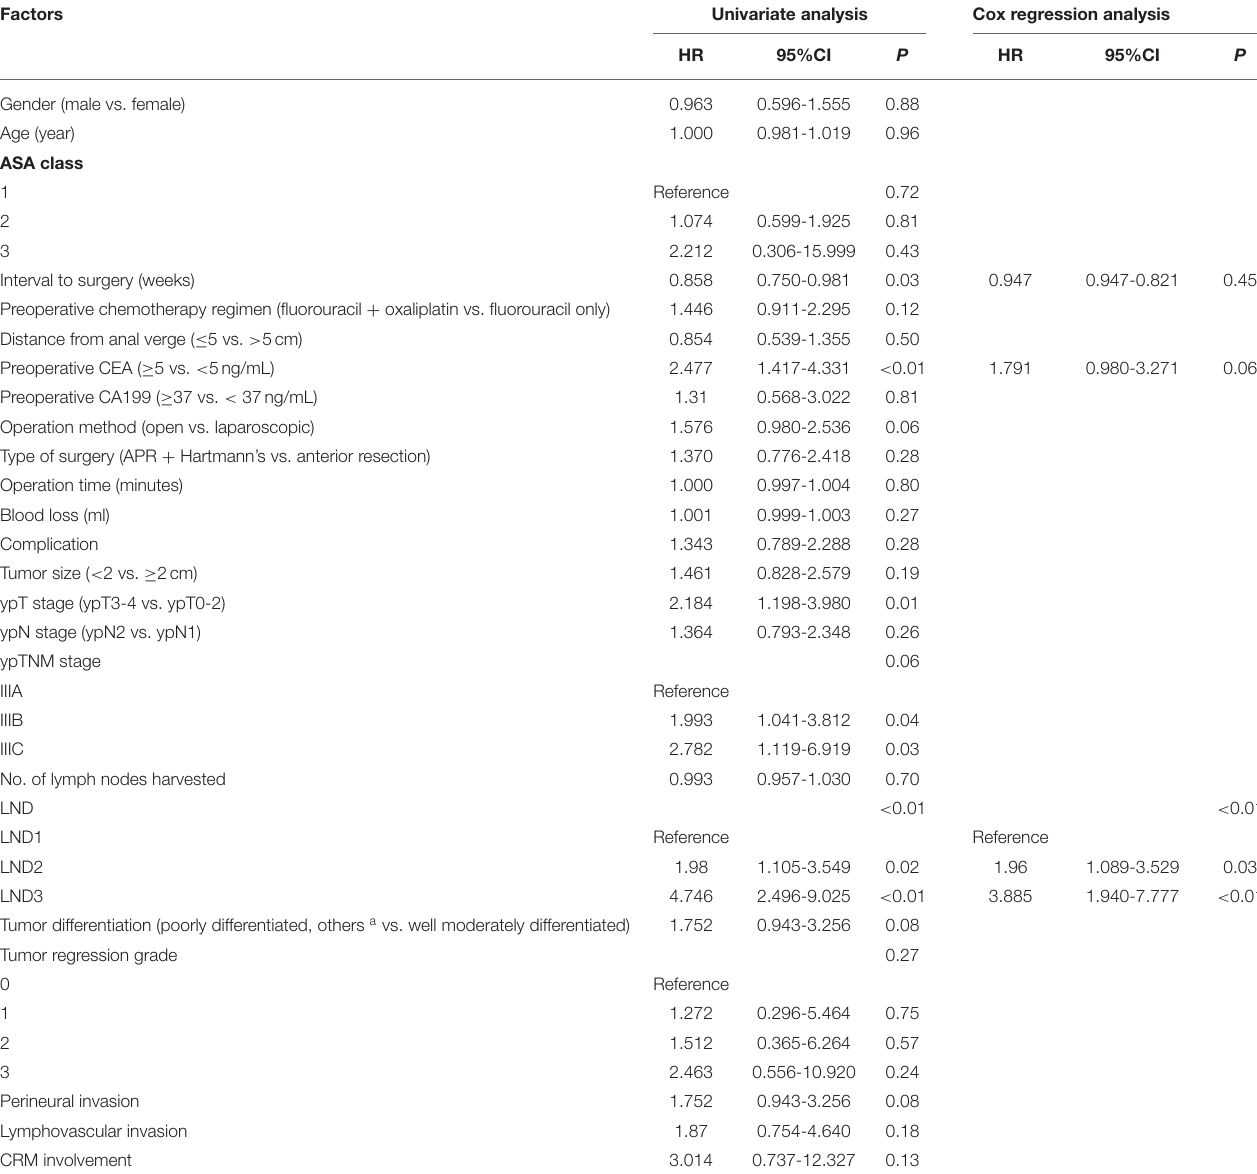
TABLE 4 | Cox regression analysis of factors for 3-year distant metastasis-free survival in ypN + rectal cancer patients after nCRT.